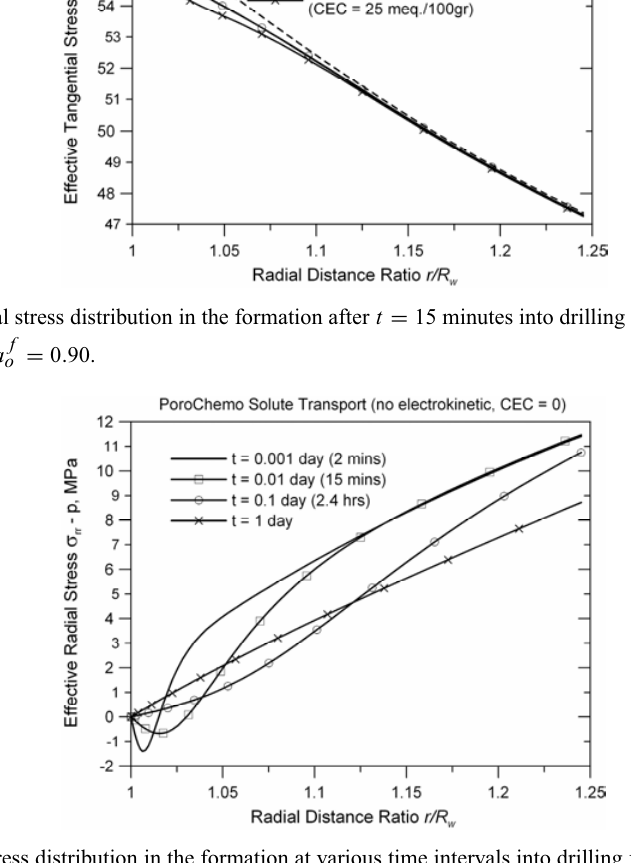
Fig. 7 – Effective radial stress distribution in the formation at various time intervals into drilling for high mud activity (low mud f . 93 > a f . 90 and ignoring electrokinetic salinity): a o = 0 mud = 0